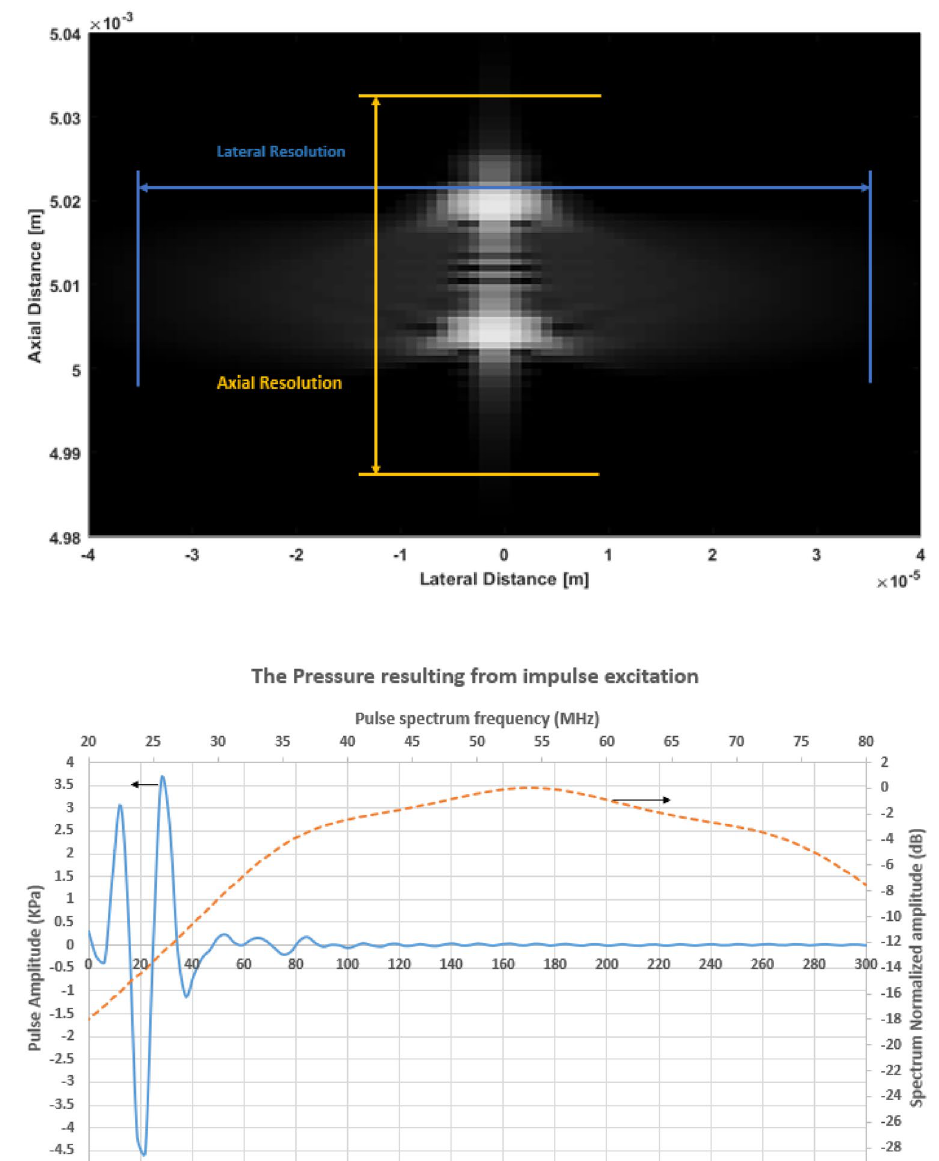
Fig. 7 Simulated cross-section imaging of a wire placed in the focal point of the optimized probe with 40 dB dynamic range. The dimensions used for determining the resolutions are shown